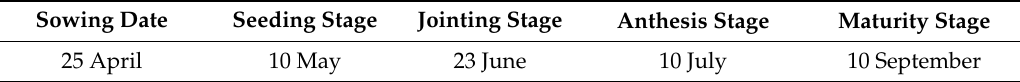
Table 5. The phenology of maize in the study area in 2012.